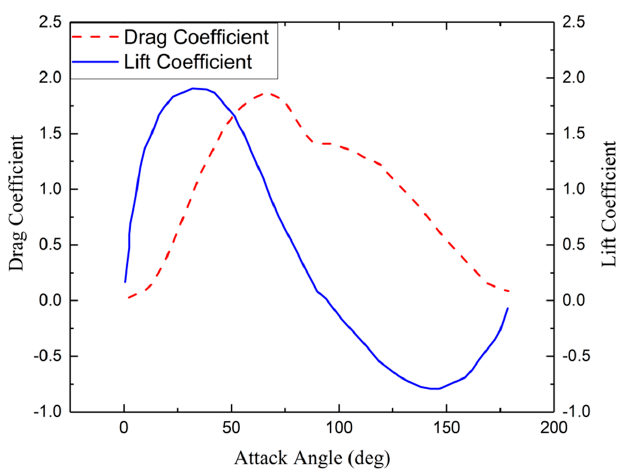
Figure 2. Power curve of the 100 kW wind turbine.